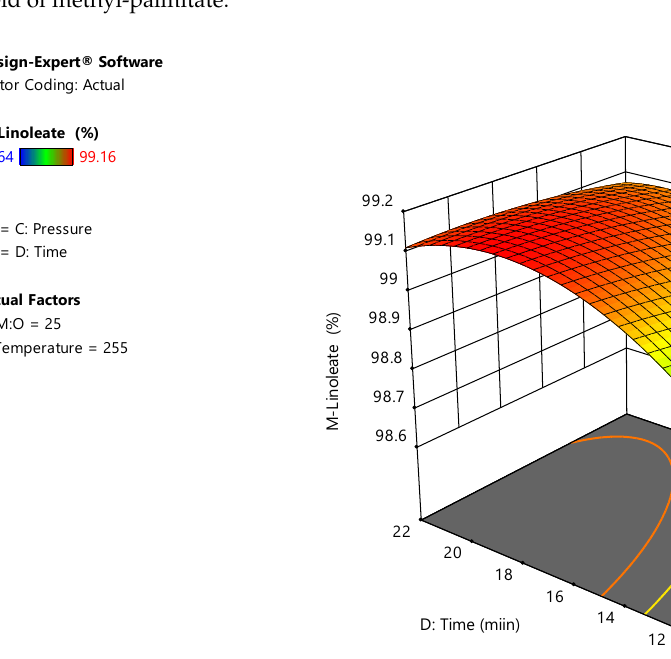
Figure A11. Response surface and contour plot for the effect of reaction pressure and time on the yield of methyl-linoleate.